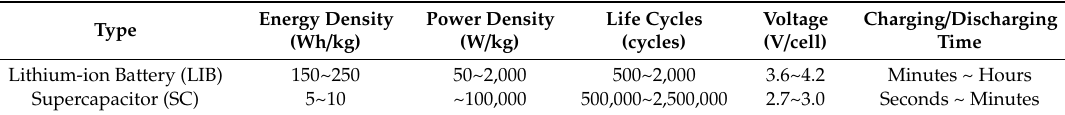
Table 1. Comparison between lithium-ion batteries (LIBs) and supercapacitors (SCs) [15–20].